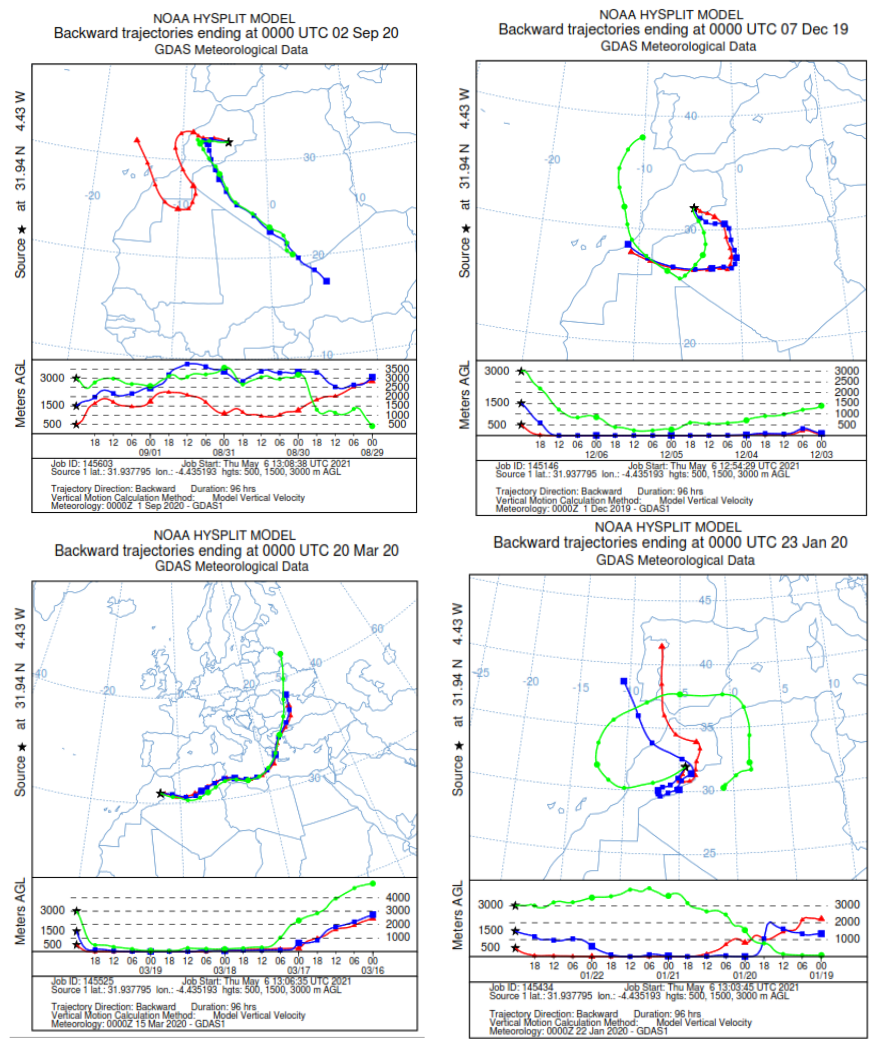
Figure 5. Typical retro-trajectories of air masses coming from the three defined Sectors (6